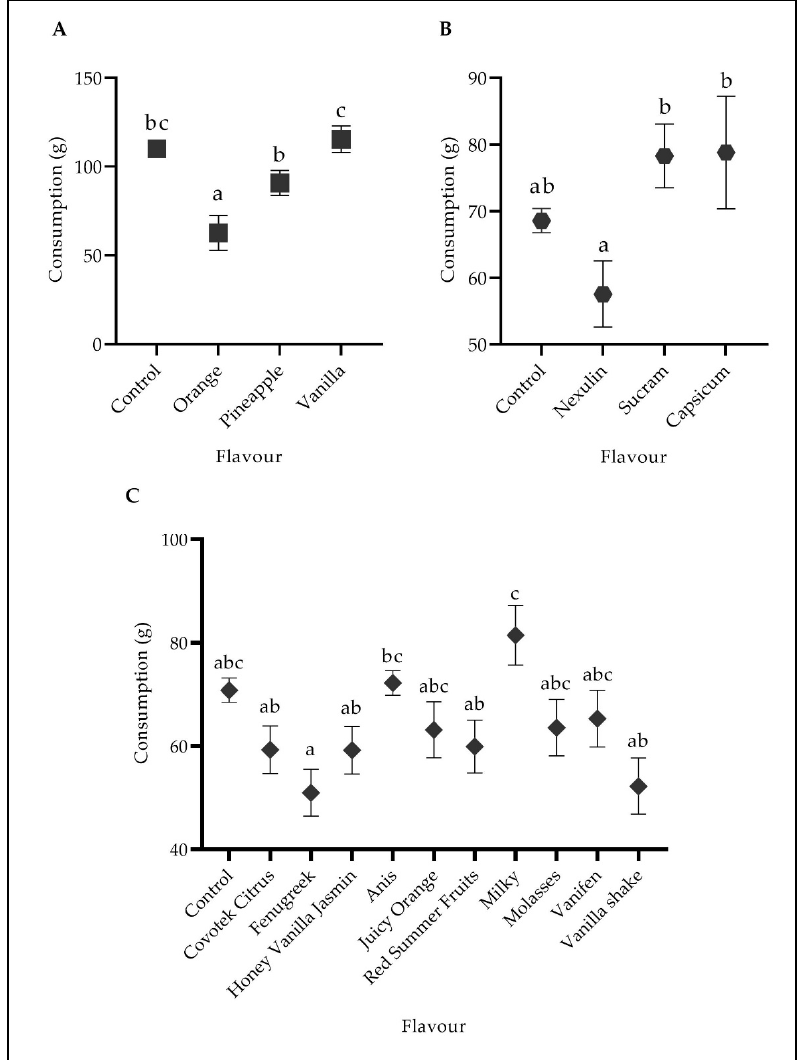
Figure 1. Consumption of the grain mixture flavoured with liquid aroma (( A ); p < 0.001), non-aroma (( B ); p = 0.020) or powder-aroma flavours (( C ); p < 0.001) by sheep offered free choice for 5 min. Means ± standard error with different leers (a–c) differ significantly ( p ≤ 0.05).